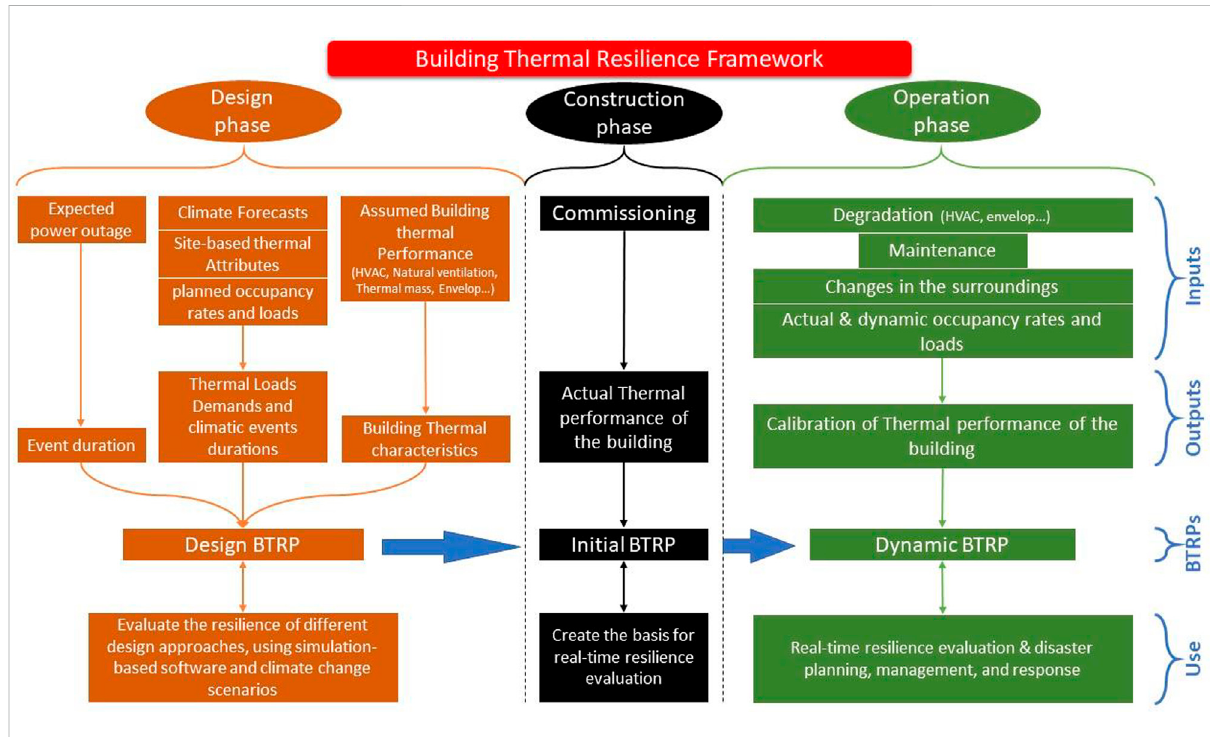
FIGURE 1 Building Thermal Resilience Framework (BTRF). During each phase of the building ’ s life cycle, a modi fi ed version of the Building Thermal ResiliencePro fi le(BTRP)iscreated.Theseversionsservedifferentneedsattheassociatedphaseandresultfromaccumulatinginputsfromthatphase with the ones from previous